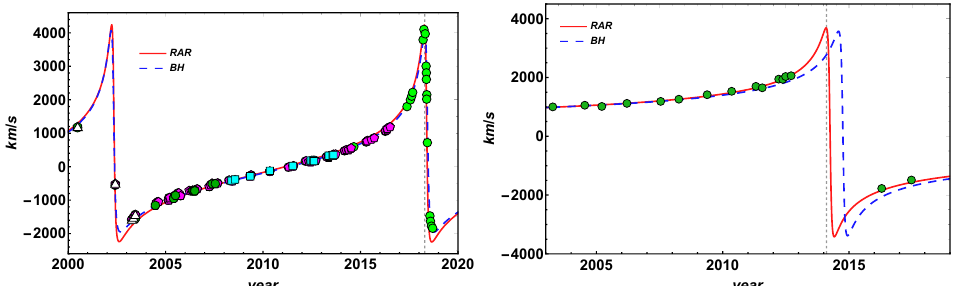
Figure 4. Theoretical and observed line-of-sight radial velocity for S2 ( left ) and G2 ( right ), calculated for the same models as in Figure 3. Both models can fit the data with similar precision S2, and, for G2, the RAR model fits the data with noticeably better precision than the BH. Reproduced from [34] with permission from Astronomy & Astrophysics, Copyright